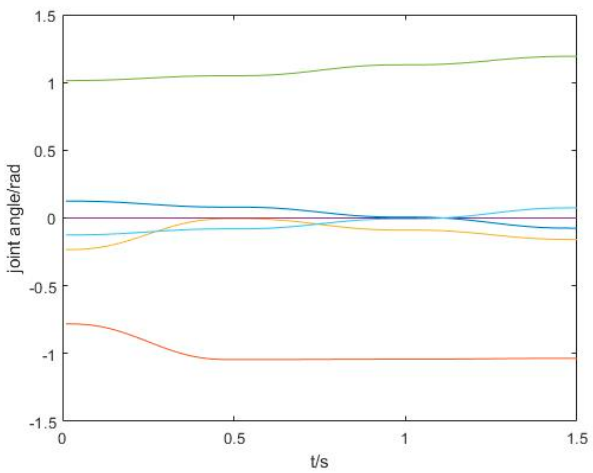
Figure 7. Variation of each joint angle during the process of obstacle avoidance.